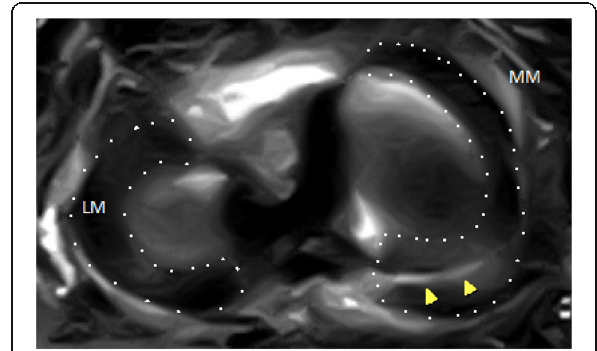
Fig. 6 Thin axial fat-saturated PD WI revealed a longitudinal non- displaced vertical tear related to the posterior horn of the medial meniscus (arrow heads). MM = medial meniscus and LM = lateral meniscus